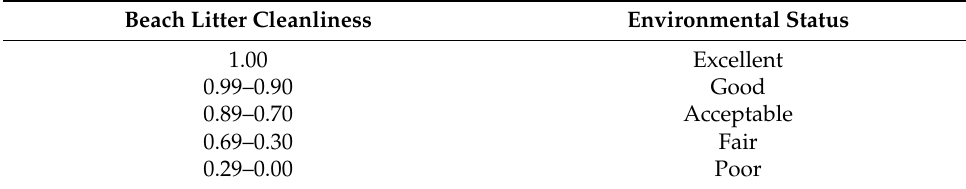
Table 3. Qualitative interpretation of beach litter